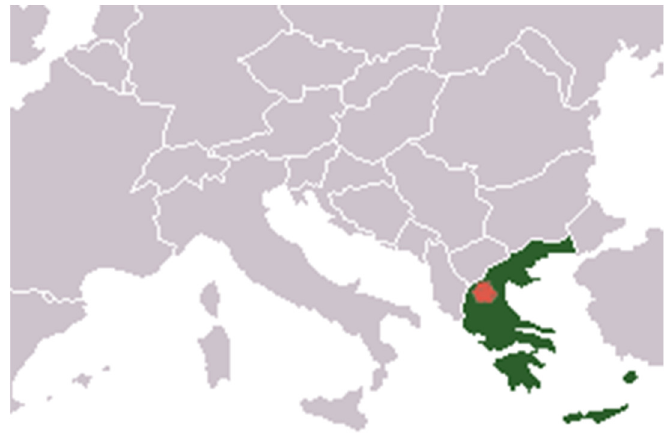
Figure 1. Location of Western Macedonia region in Greece.